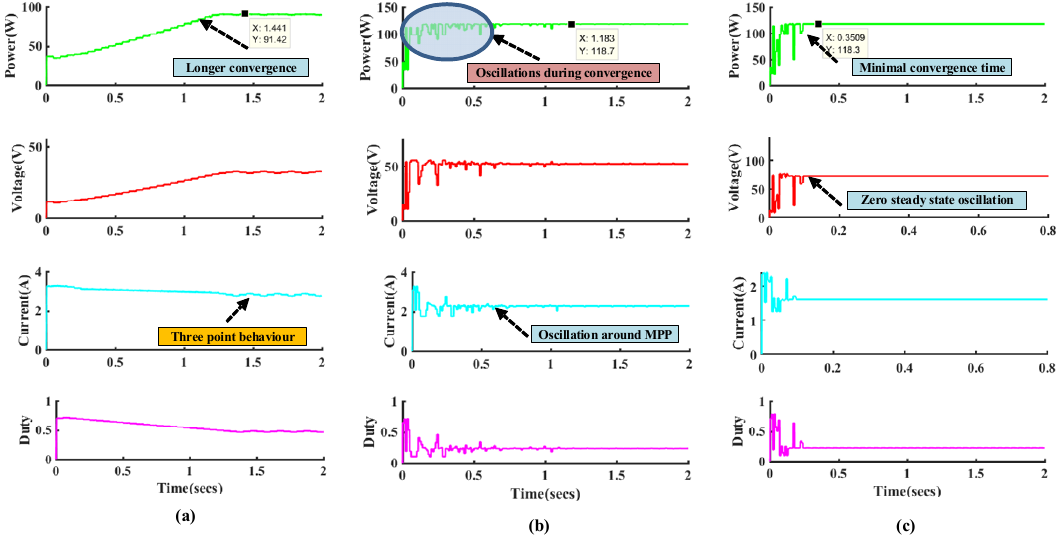
Figure 15. Simulated waveforms of ( a ) P&O, ( b ) PSO, and ( c ) SHO methods for Pattern